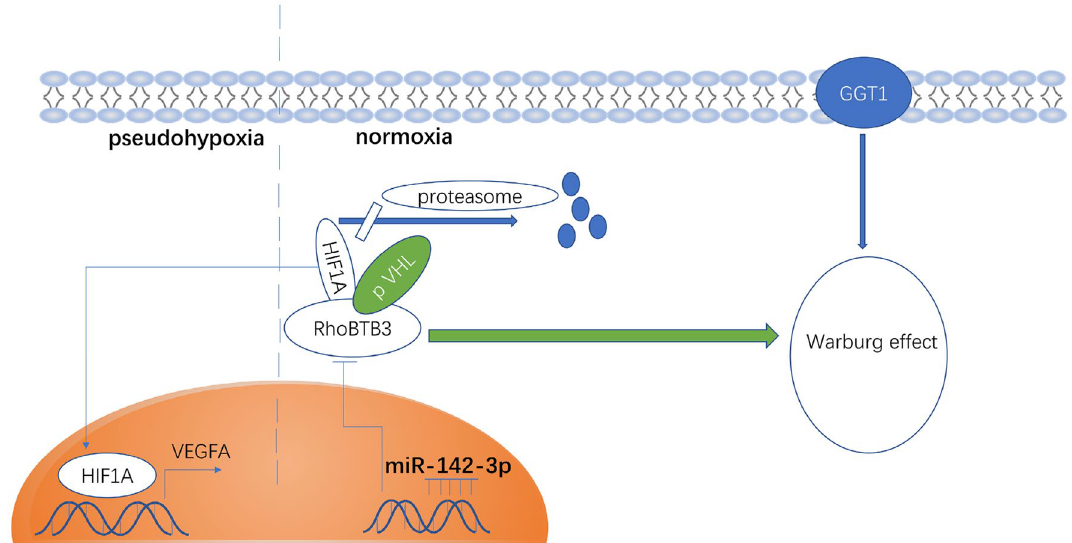
Figure 6. The hypothesis of the mechanism of microRNA-142-3p promotes renal cell carcinoma